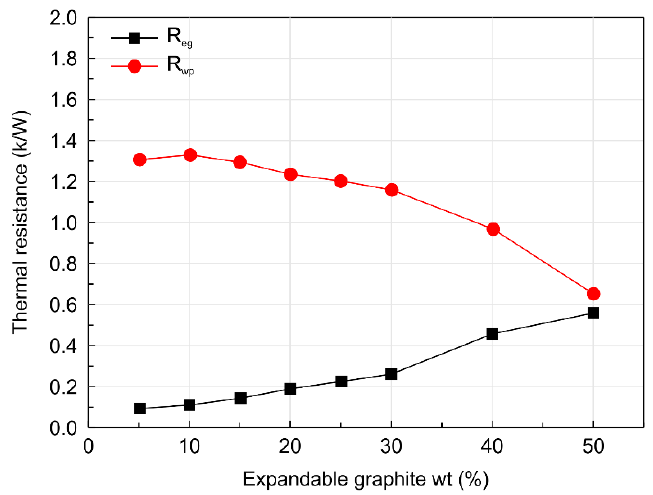
Figure 15. Thermal resistance variations with expandable graphite content.